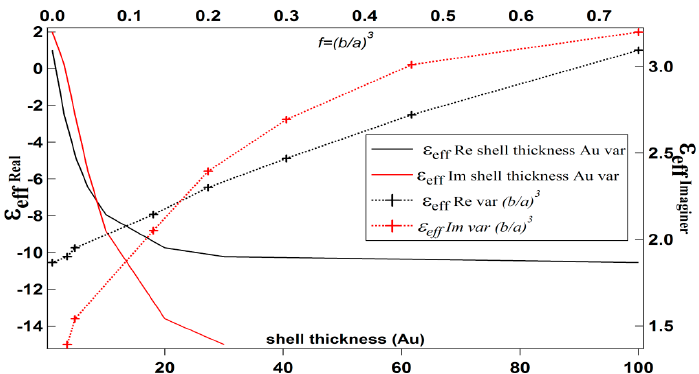
Figure 4. The effective permittivity of a core-shell for variations of shell thickness and f = ( b / a ) 3 .